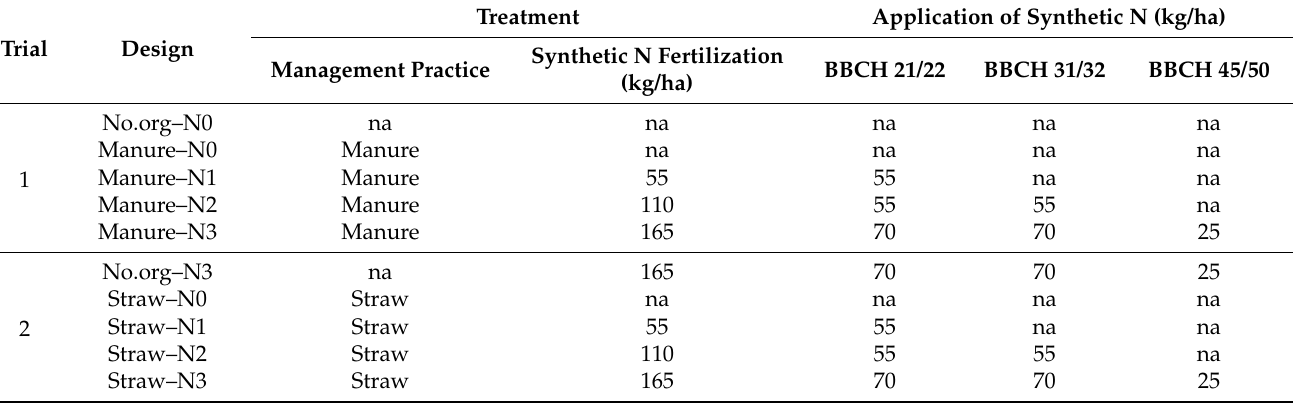
Table 5. Treatment combinations of synthetic N rate and agronomic management practices of the long-term experiment used for oats in this